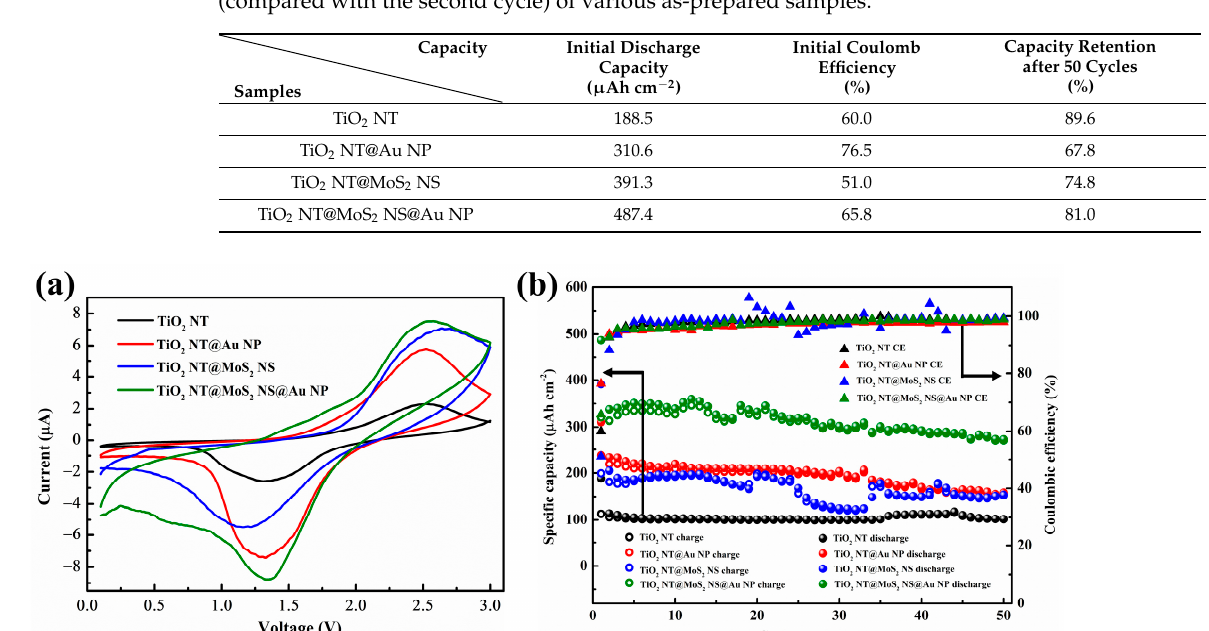
Figure 6. The initial three charge/discharge pro fi les of ( a ) TiO 2 NT, ( b ) TiO 2 NT@Au NP, ( c ) TiO 2 NT@MoS 2 NS, and ( d ) TiO 2 NT@MoS 2 NS@Au NP composites, under 100 µA cm − 2 . NT@MoS 2 NS, and ( d ) TiO 2 NT@MoS 2 NS@Au NP composites, under 100 µ A cm − 2 . Table 1. Initial discharge capacity, initial coulomb efficiency, and capacity retention rate after 50 cycles (compared with the second cycle) of various as-prepared samples.